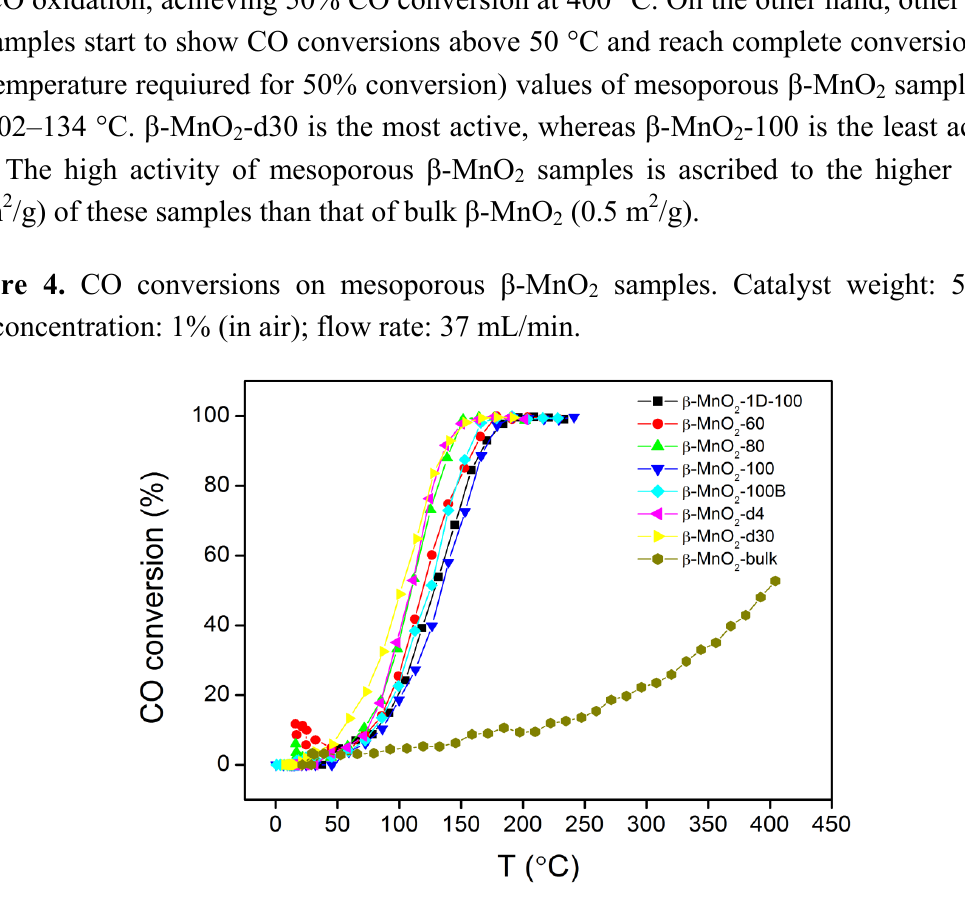
Figure 4. CO conversions on mesoporous β -MnO